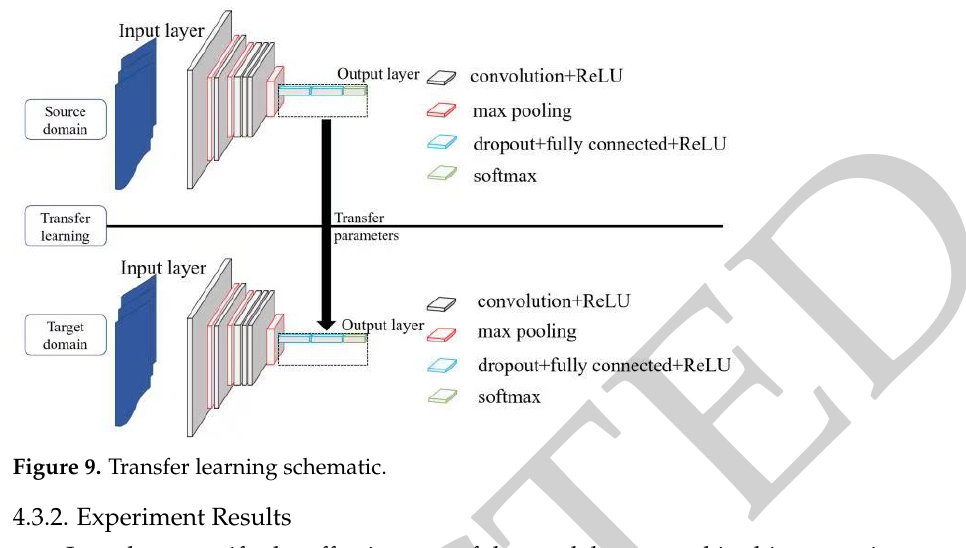
Figure 9. Transfer learning schematic.